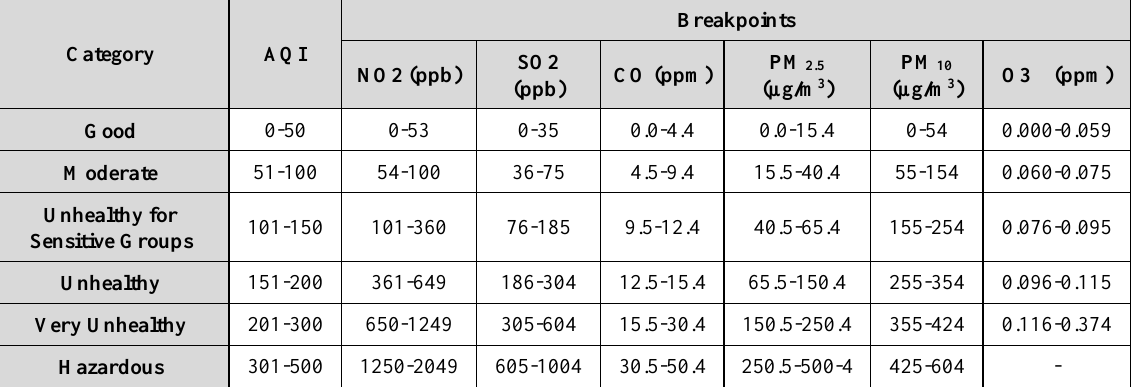
Table 1. Breakpoints for the AQI